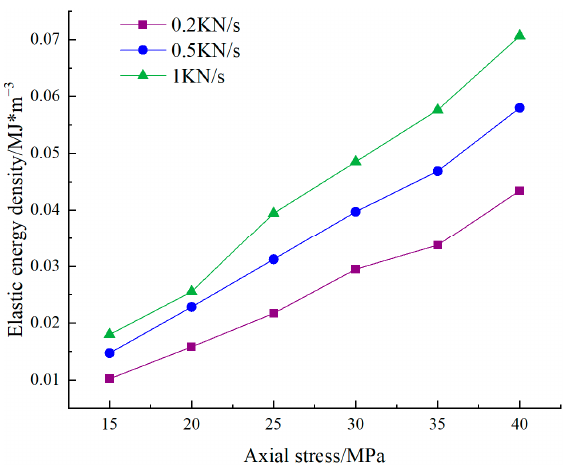
Figure 8. Elastic energy density change curve.